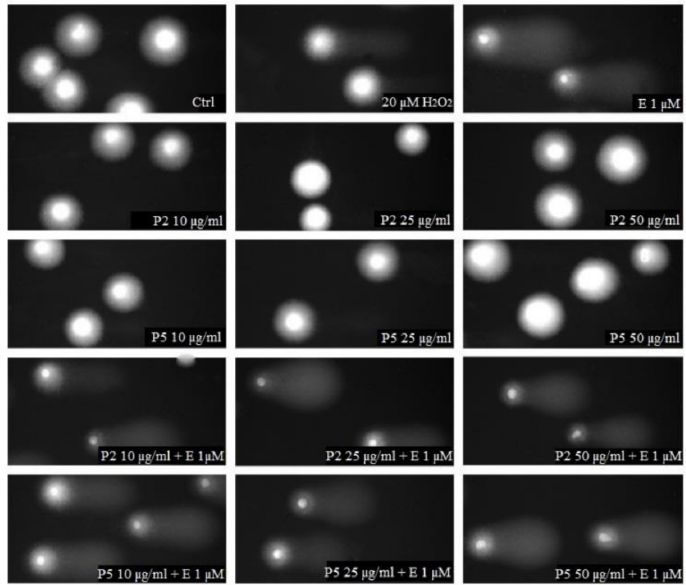
Figure 5. Representative pictures of comets obtained in the alkaline version of the comet assay after incubation of HL-60 cells with 10, 25 or 50 µ g/mL P2 and P5 kaempferol derivatives and 1 µ M etoposide (E). The figure also contains pictures of comets from negative control (Ctrl) and positive control (cells incubated with H 2 O 2 at 20 µ M for 15 min on